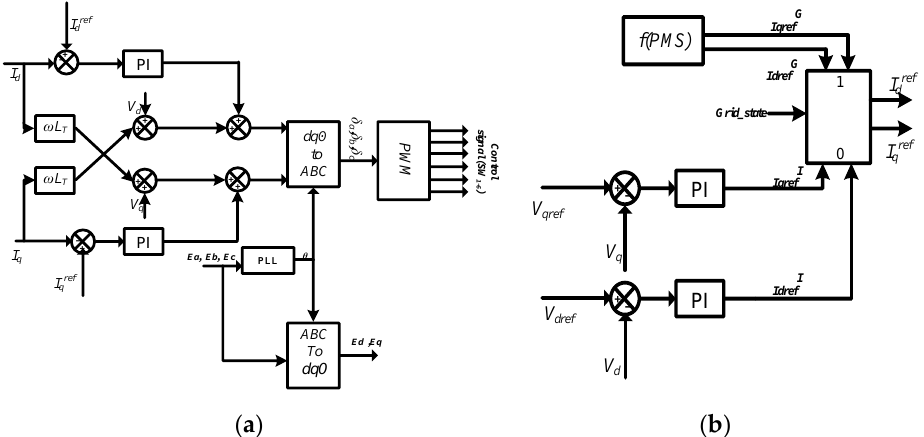
Figure 8. ( a ) Control scheme for the interlinking converter; ( b ) d-q reference current selection for converter .